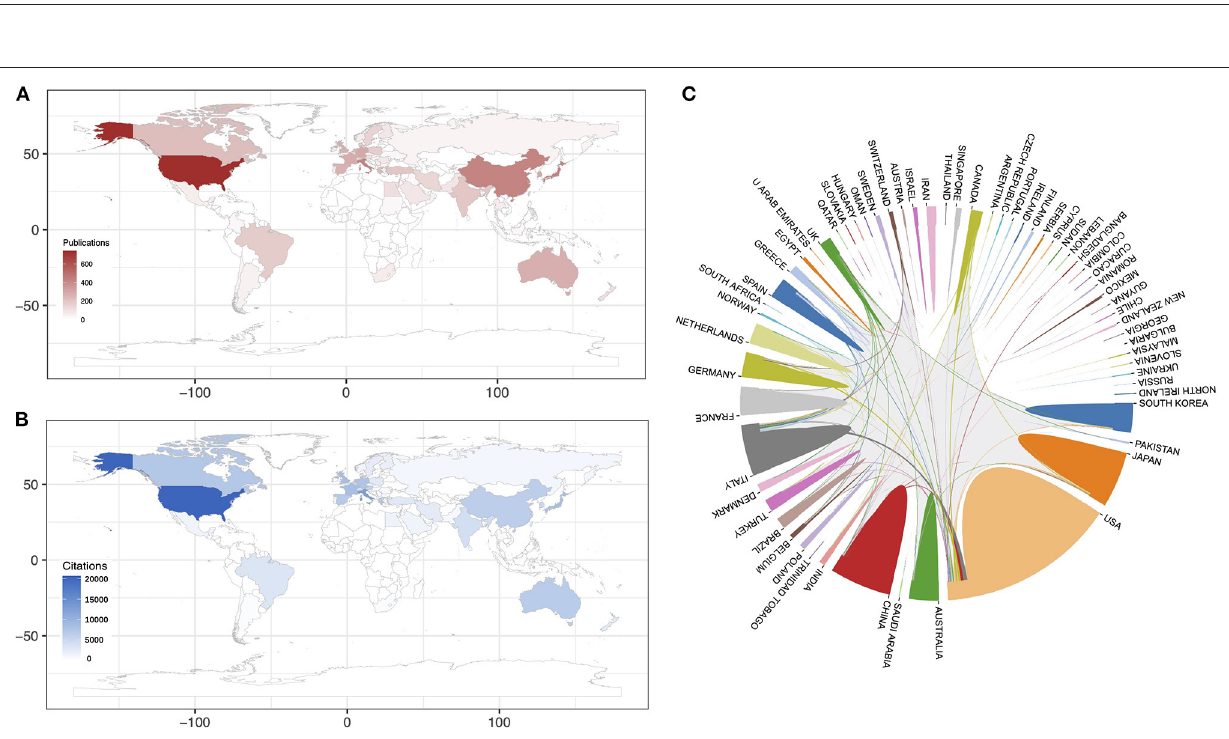
Frontiers in Neurology | www.frontiersin.org